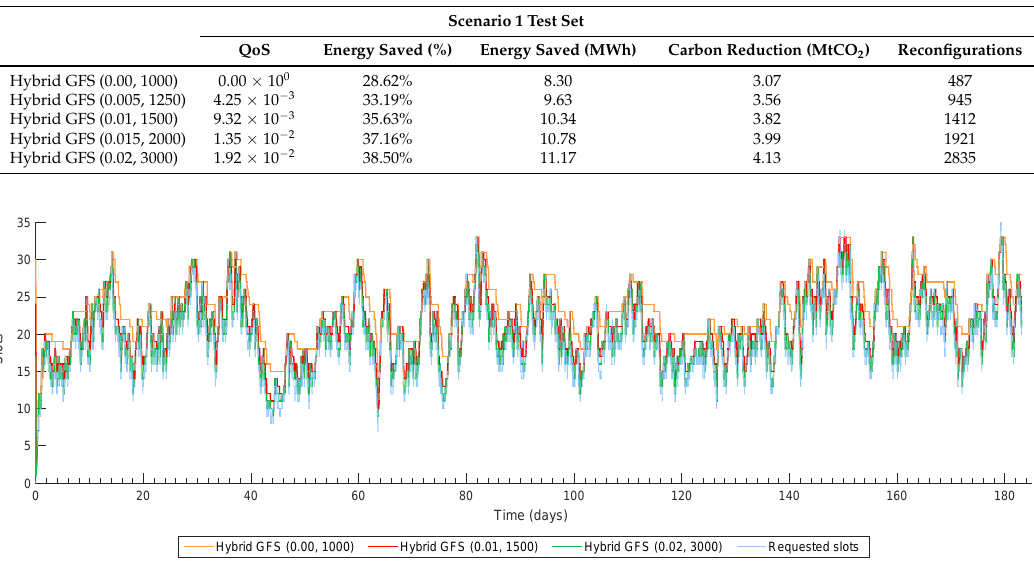
Table 2. Experiment results for the test set of scenario 1.